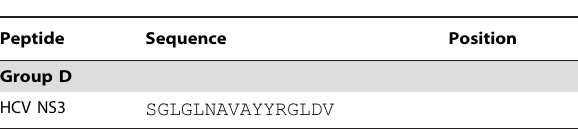
Table 1. Peptides derived from BP26 of B. melitensis